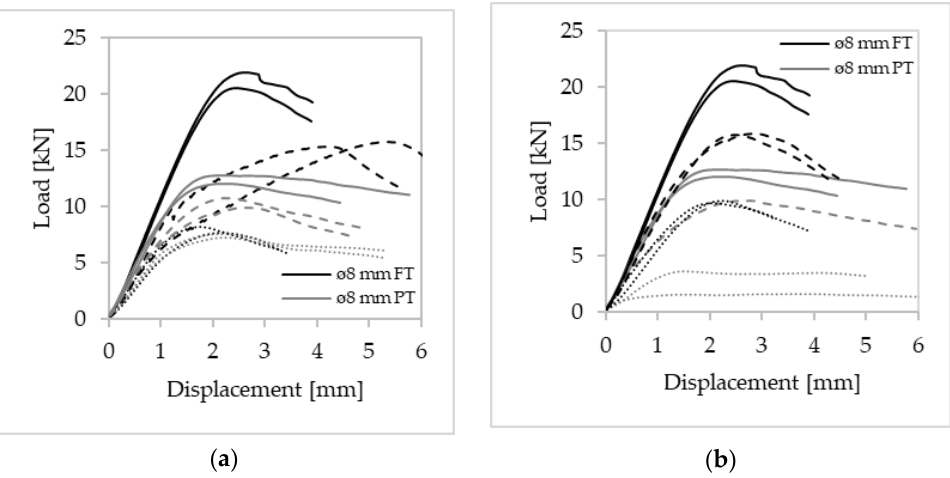
Figure 10. Load-displacement curves for Ø 8 mm screws: ( a ) Exposed head; ( b ) Exposed tip. Solid line for ambient conditions, dashed line for one hour of exposure and dotted line for two hours of exposure.